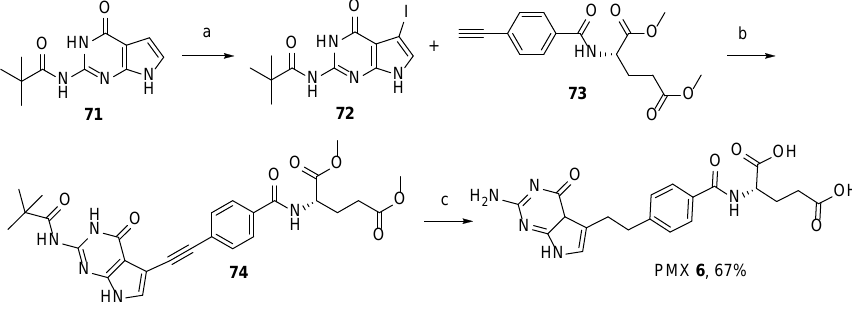
Scheme 24. Synthesis of Pemetrexed starting from ethyl-4-(3-oxopropyl)benzoate 67